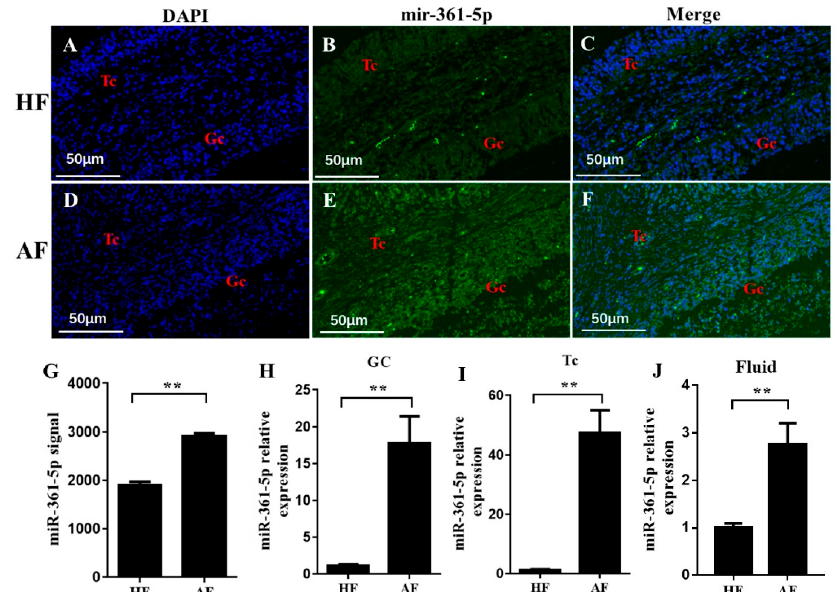
Figure 2. Expression of the mir-361-5p in healthy and atretic antral follicles. ( A – F ): RNA-FISH was utilized to examine the localization of mir-361-5p in healthy and atretic antral follicles; ( G ): Signal intensity of mir-361-5p in follicles detected by µ Paraflo ™ microfluidic chip; ( H – J ): relative expression levels of mir-361-5p in GC, TC, and follicle fluid, respectively, detected by qRT-PCR. HF, healthy follicle; AF, atretic follicle; GC, granulosa cell; TC, theca cell; scale bar = 50 µ m. Data are expressed as the mean ± SEM. ** p < 0.01.